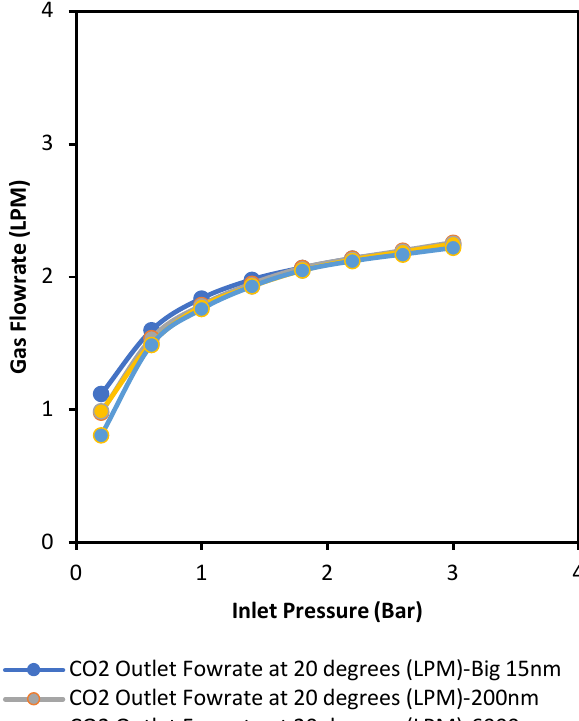
Figure 5. Isothermic effect of pressure on methane flowrate with each membrane at 100 °C.